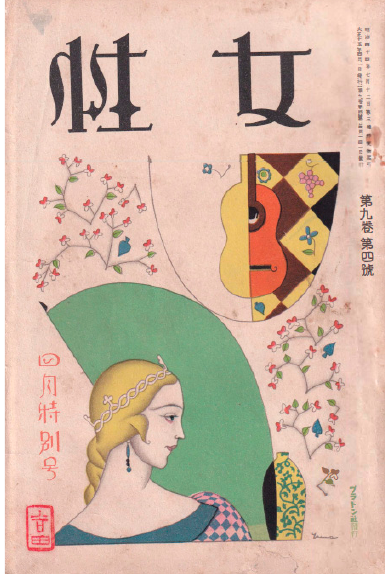
Figure 2. Cover of Josei April 1926 issue.